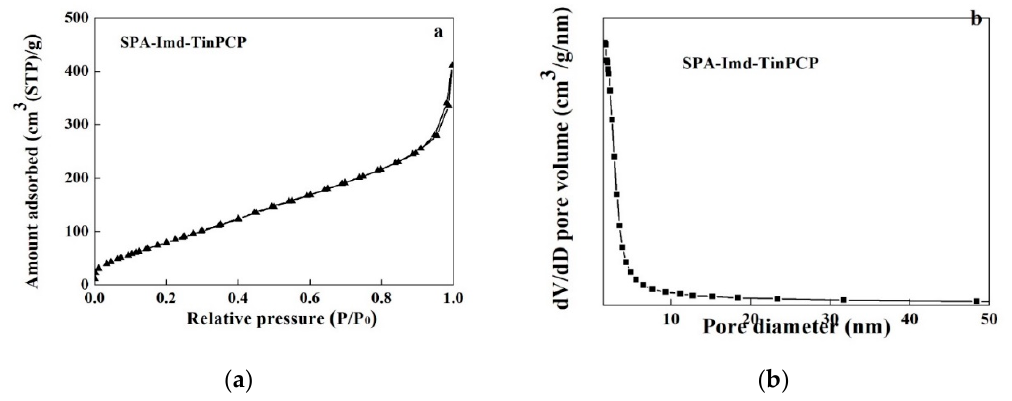
Figure 7. ( a ) N 2 adsorption and desorption isotherms measured at 77 K for SPA-Imd-TinPCP; ( b ) pore size distribution of SPA-Imd-TinPCP.